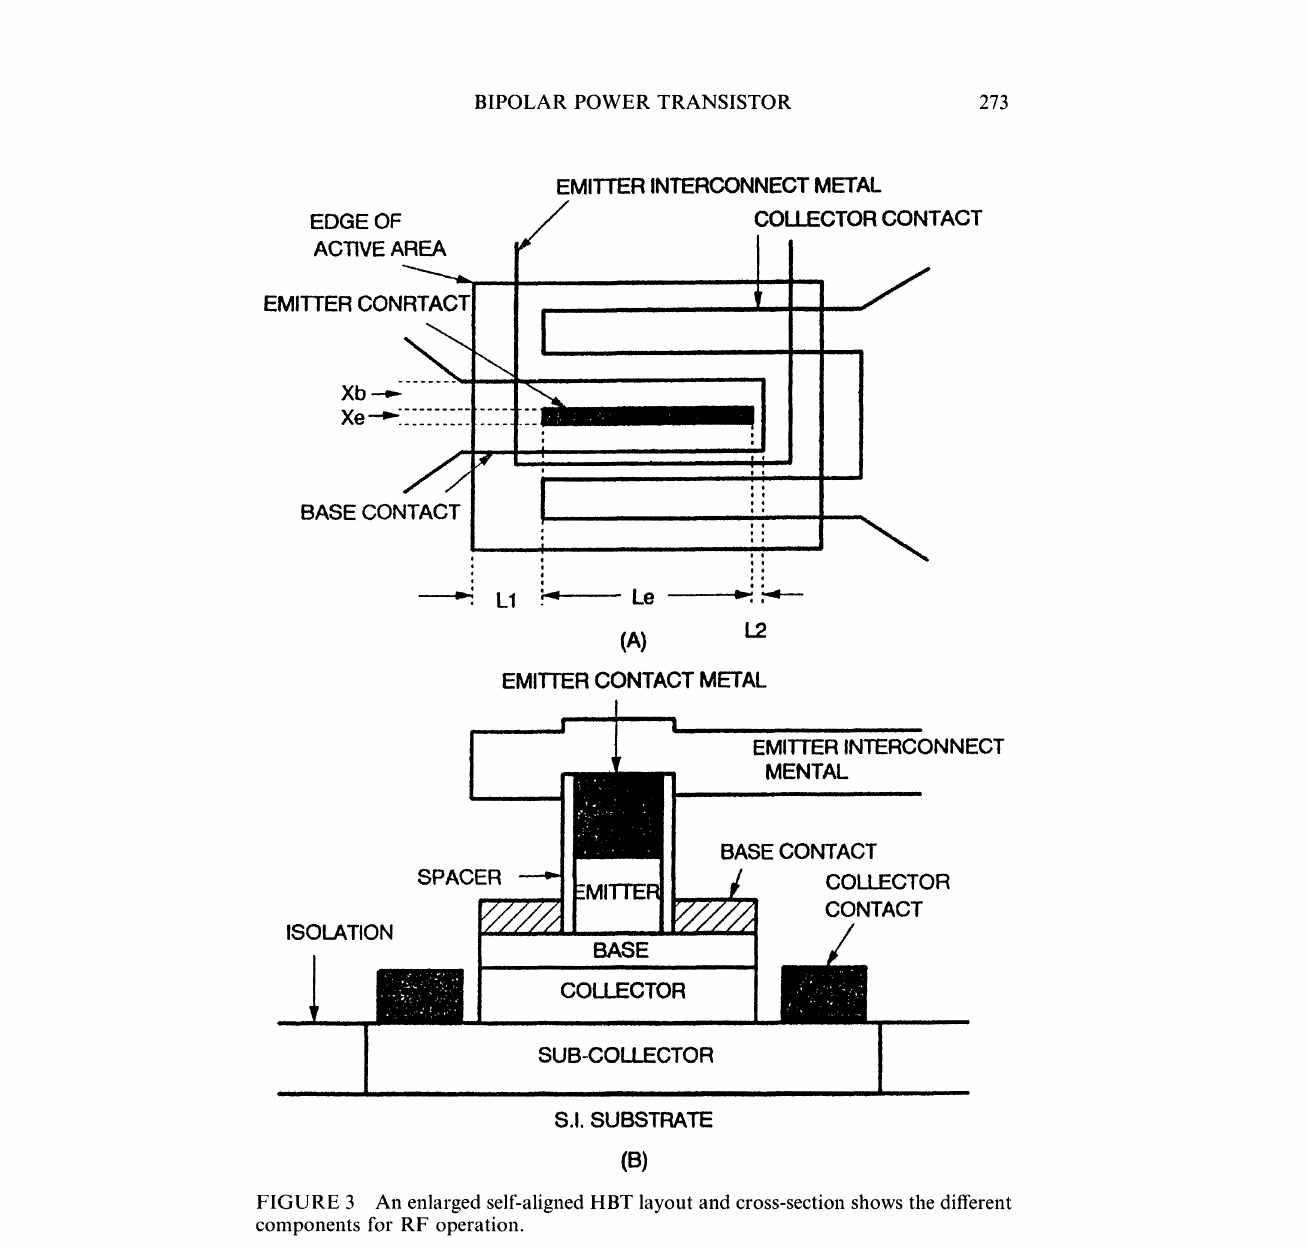
FIGURE 3 An enlarged self-aligned HBT layout and cross-section shows the different components for RF